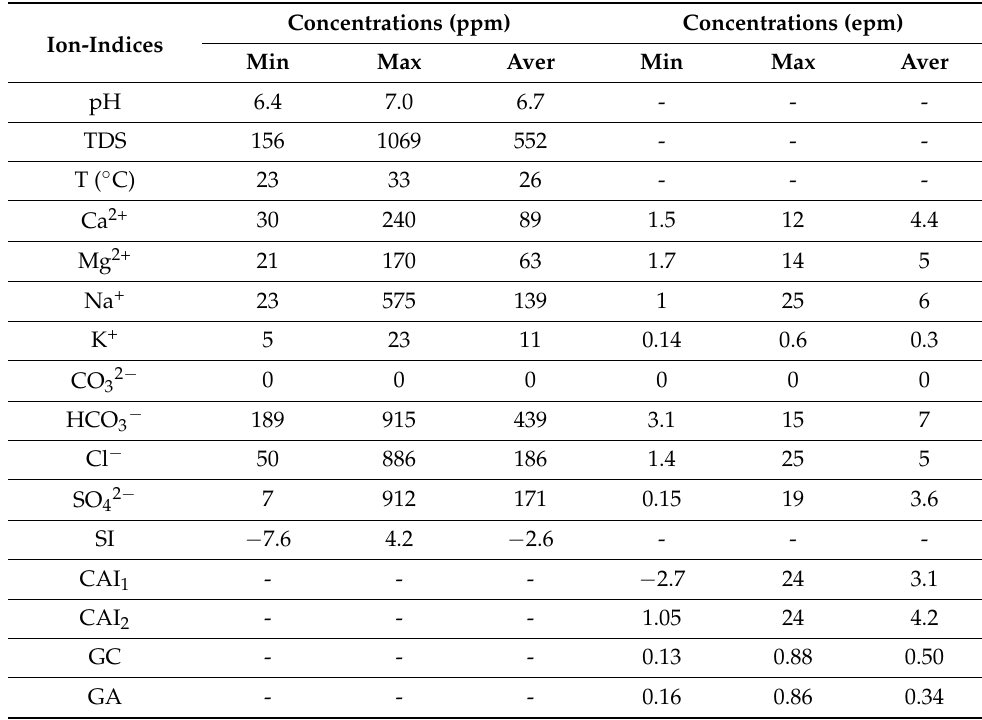
Table 1. The ion concentrations and physicochemical values in the studied groundwater